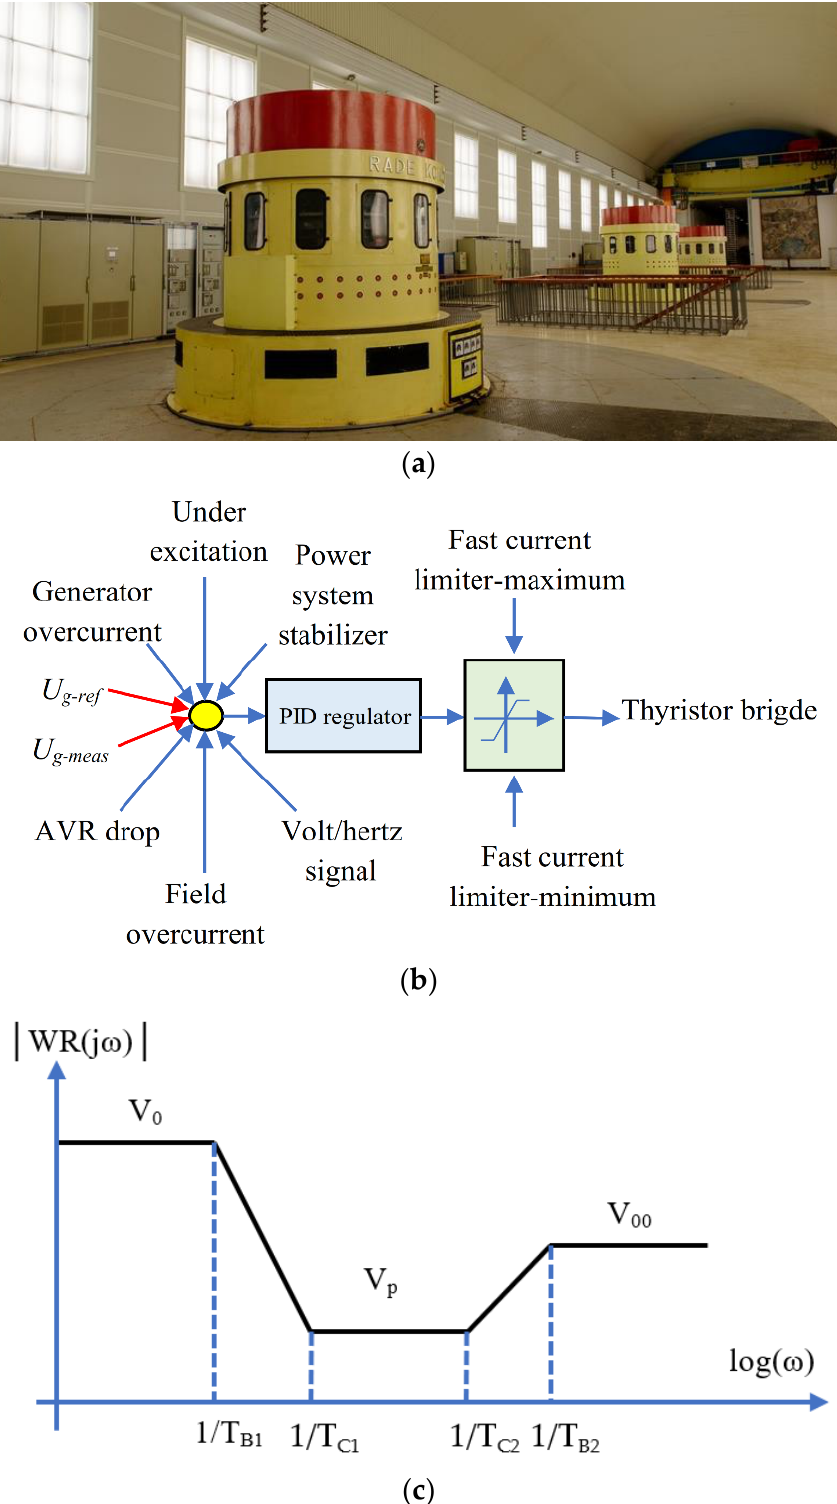
Figure 19. Experimental setup: ( a ) 120 MVA generator from HPP Piva, ( b ) AVR model in HPP Piva, ( c ) Bode characteristic of the lead-lag compensator.